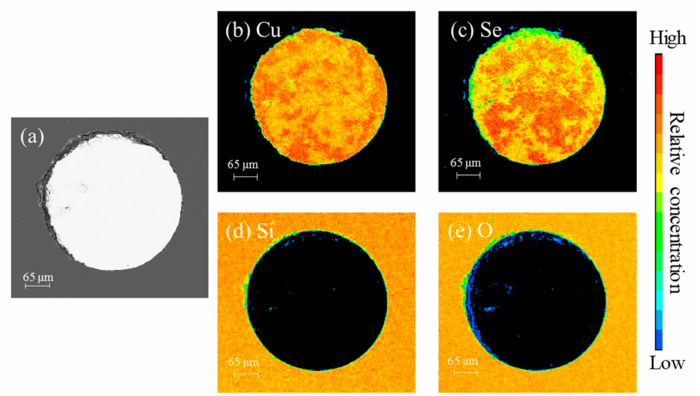
Figure 1. ( a ) Cross-section electronic micrograph of the Cu-Se core fiber; element distribution of ( b ) Cu, ( c ) Se, ( d ) Si, and ( e ) O in the fiber core region. The color palette at the right exhibits the relative concentration of the related element in ( b – e ) from low to high.